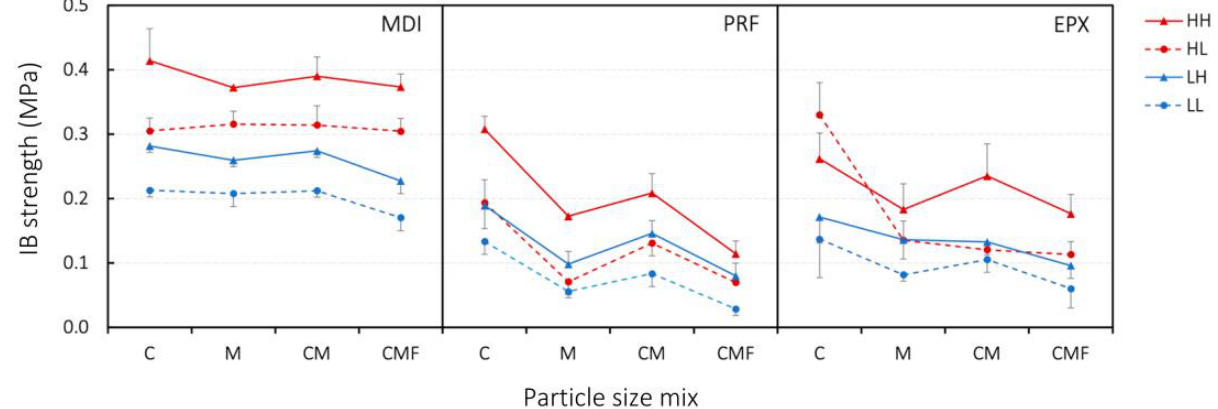
Figure 8. IB strength of panel variants as a function of particle size mix. C = 100% coarse, M = 100% medium, CM = 50% coarse and 50% medium, CMF = 25% coarse, 50% medium, 25% fine, HH = High particle loading and high adhesive content; HL = High particle loading and low adhesive content; LH = Low particle loading and high adhesive content; LL = Low particle loading and low adhesive content.